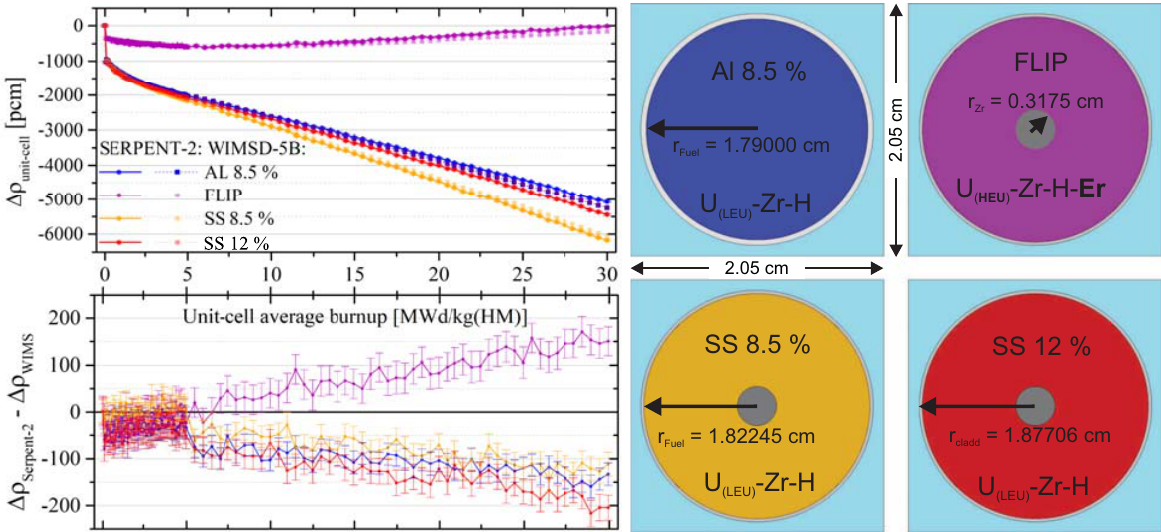
Figure 4: Changes of excess reactivity due to unit-cell burnup for four different types of TRIGA fuel. Serpent-2 results are compared to